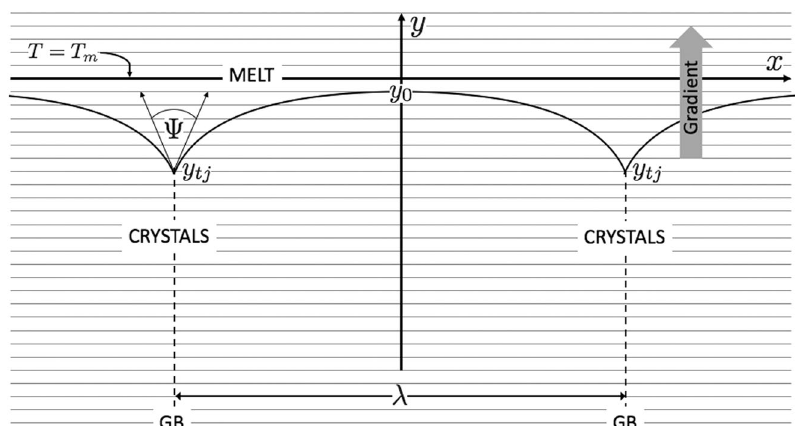
Fig. 2 Grain boundary grooves, GBGs, linked along a stationary curved s / ℓ interface. Periodic GBGs separate bulk crystal and melt that support energy fl ow through a constant thermal gradient, pointing in the + y direction. The thermal fi eld constraining the s / ℓ interface is illustrated here by a uniform grid of isotherms, where the x -axis coincides with the system ’ s melting-point, T m . Triple junctions formed at each grain boundary (GB) intersection are spaced apart a distance λ [m] along the x -axis. All triple junctions are located on coordinate y tj . Each triple junction supports a constant dihedral angle, 0 ≤ Ψ < π . Midpoints of the GBGs are located periodically at coordinate y 0 < 0, where the slope is zero, and curvature